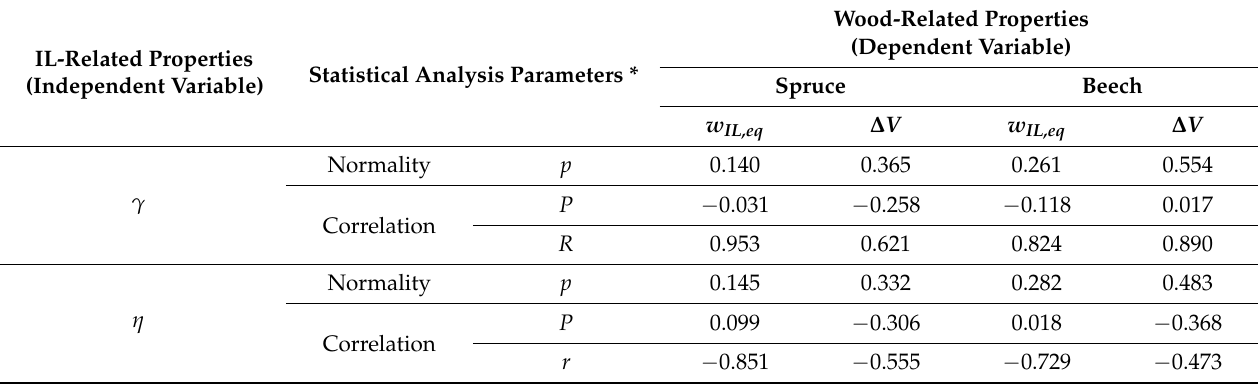
Table 1. Statistical analysis of the dependence between selected wood-related properties (dependent variables) and ionic liquid-related properties (independent